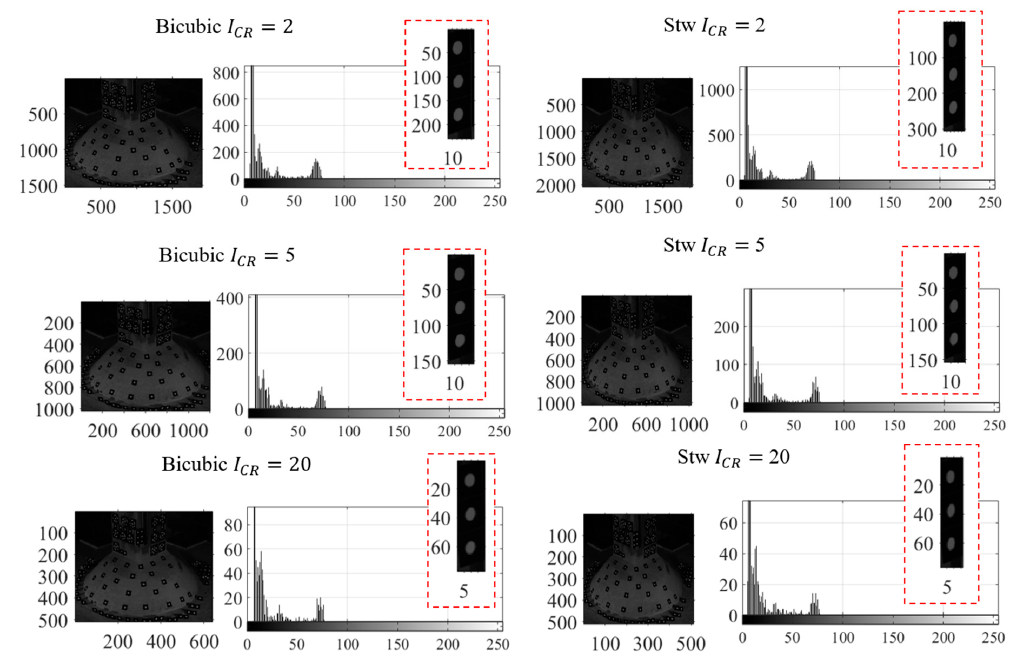
Figure 6. Compressed images from non-adaptive linear interpolation using Bicubic algorithm and wavelet transform using Stw compression for three compression ratios ( I CR = 2, 5, and 20) with histograms of the local area of the monitored optical targets from the 1-inch block experiment. By inspecting the histogram of the local area of the three optical targets with 𝐼 (cid:3004)(cid:3019) = 2 in Figure